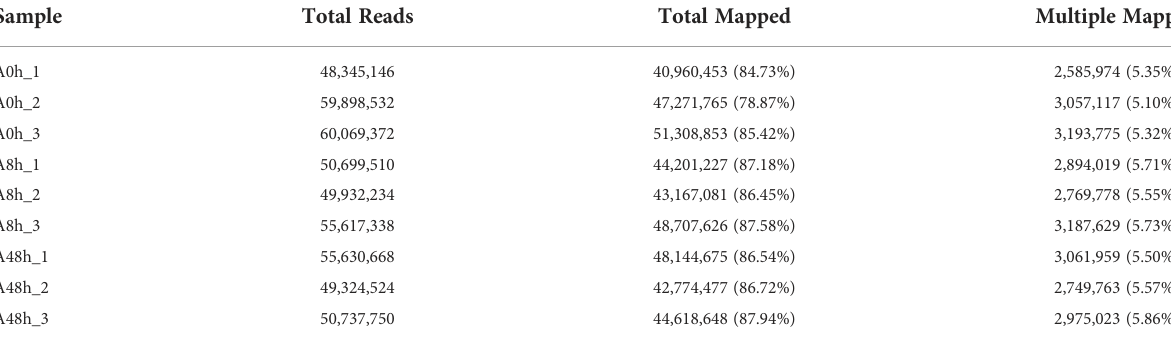
TABLE 3 The percentage of reads mapped to the reference genome. Sample Total Reads Total